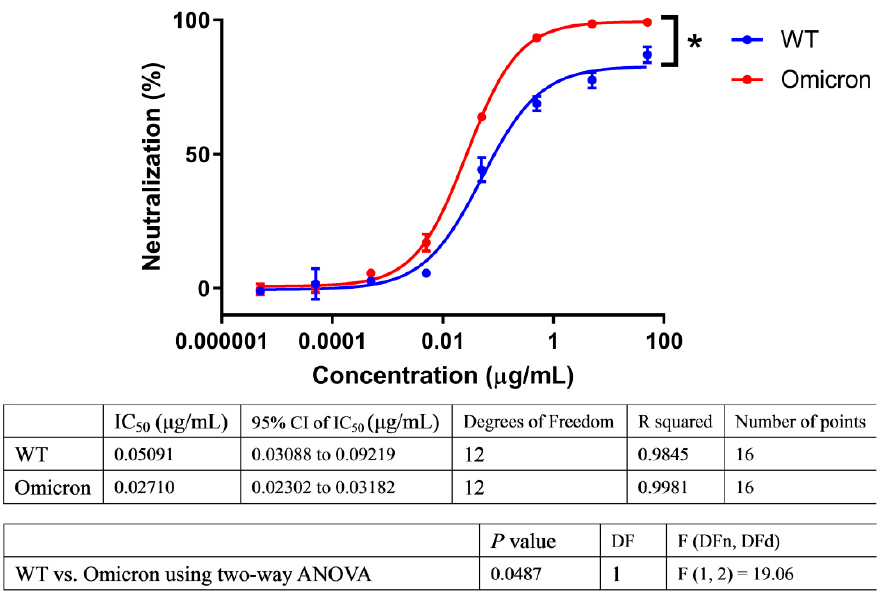
Figure 1. ACE2-Fc showed enhanced neutralization ability against Omicron. Lentiviral particles pseudotyped with S protein of wild-type (WT) or Omicron were used to evaluate their susceptibility to ACE2-Fc neutralization in parallel. Neutralization ratios were calculated based on luminescent units detected (mean ± SD, n = 2). Dose-response neutralization curves were fit to a four-parameter logistic equation by nonlinear regression analysis. Means were compared using two-way ANOVA statistical analysis with testing level (alpha) of 0.05. * p < 0.05.